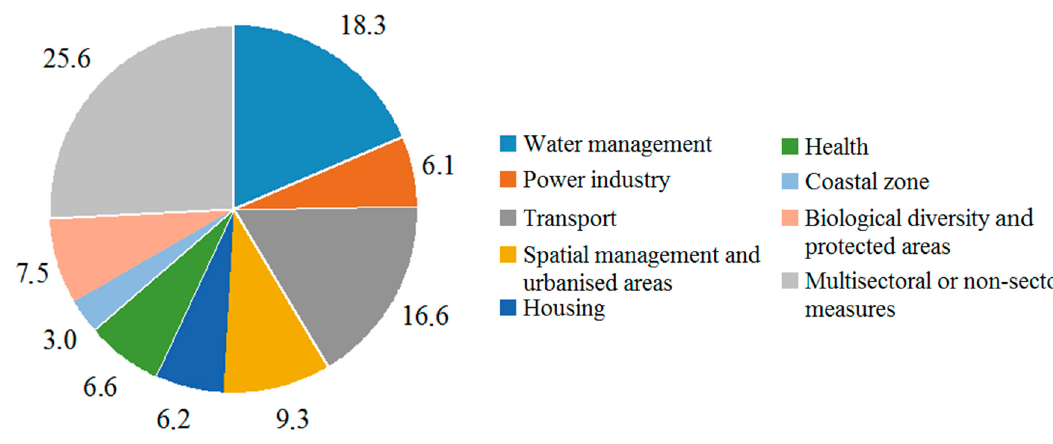
Figure 4. Share of the number of measures by sectors vulnerable to climate change (in %) in the total number of actions included in the MAPs of selected cities in Poland.